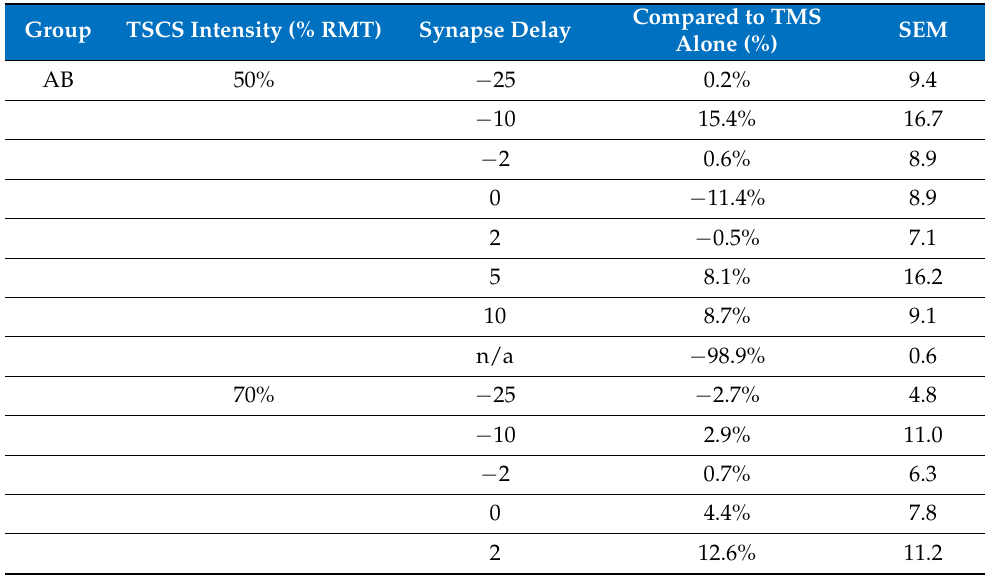
Table 5. F-wave responses to conditioning TSCS pulses.